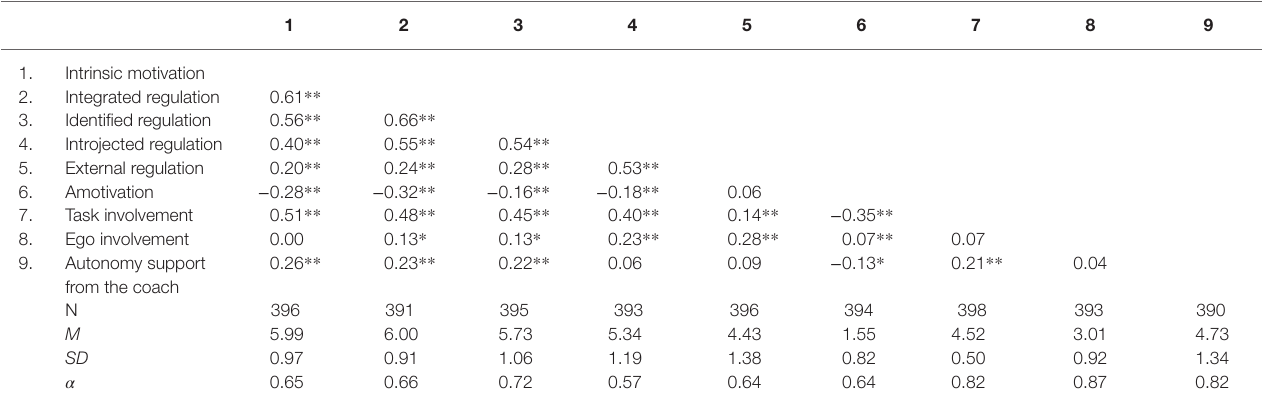
TABLE 1 | Correlation between all variables.